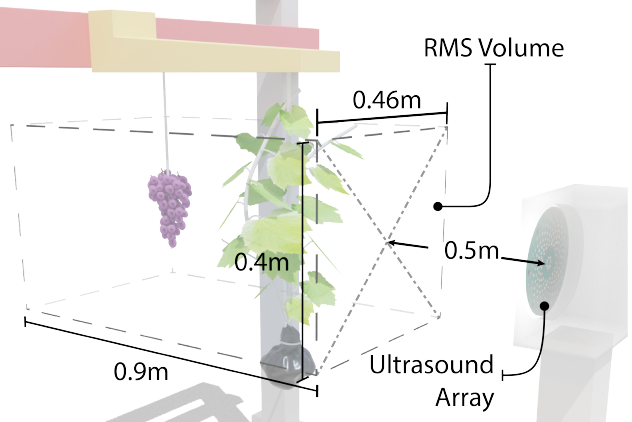
Figure 11. Diagram showing the scan volume used for the RMS processing for grape and leaf